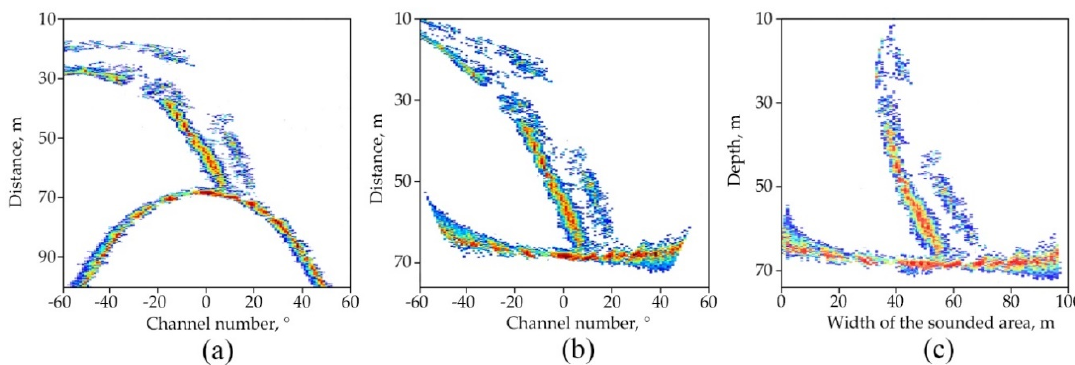
Figure 2. A multibeam sonar image before ( a ) and after ( b , c ) correction for the shift in depth ( b ) and insonified area ( c ).